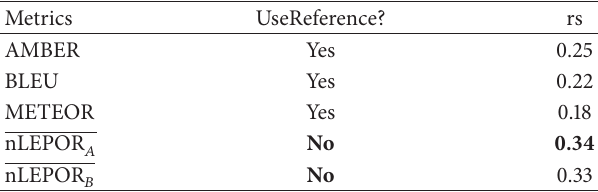
Table 2: Performances on the WMT11 training corpora.